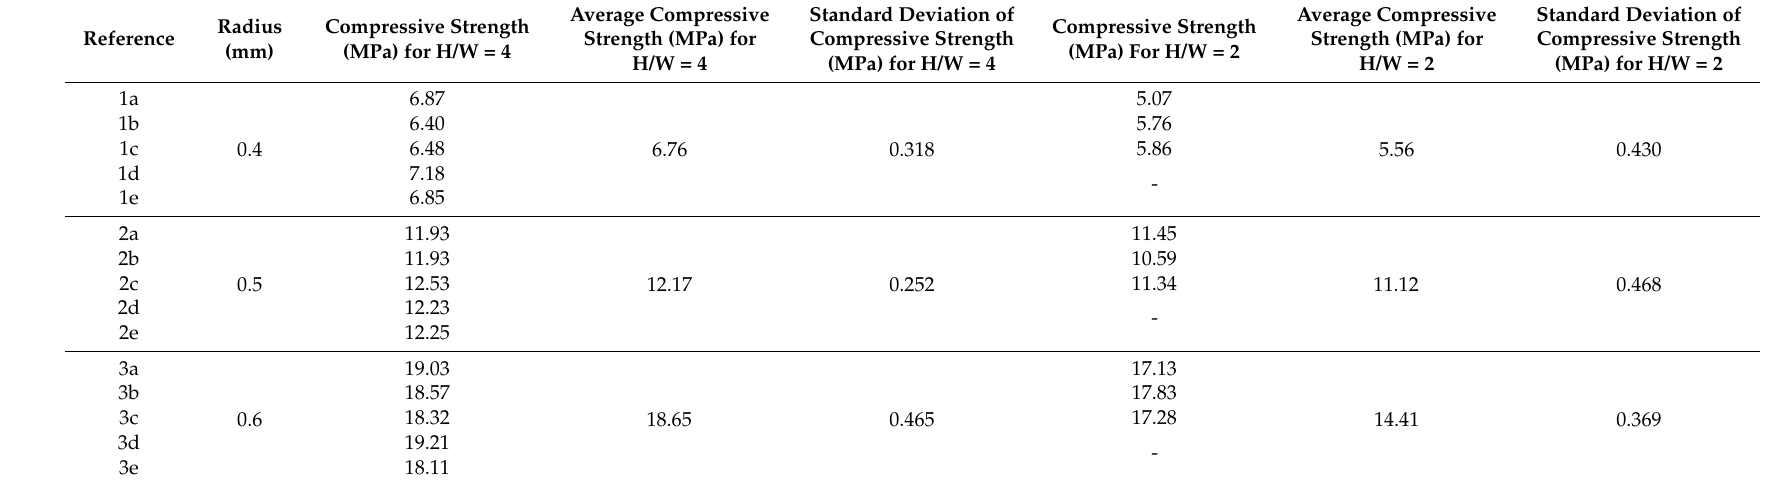
Table 5. Ultimate Compressive Strength (UCS) equivalent to each structure of the octet-truss obtained from the compression